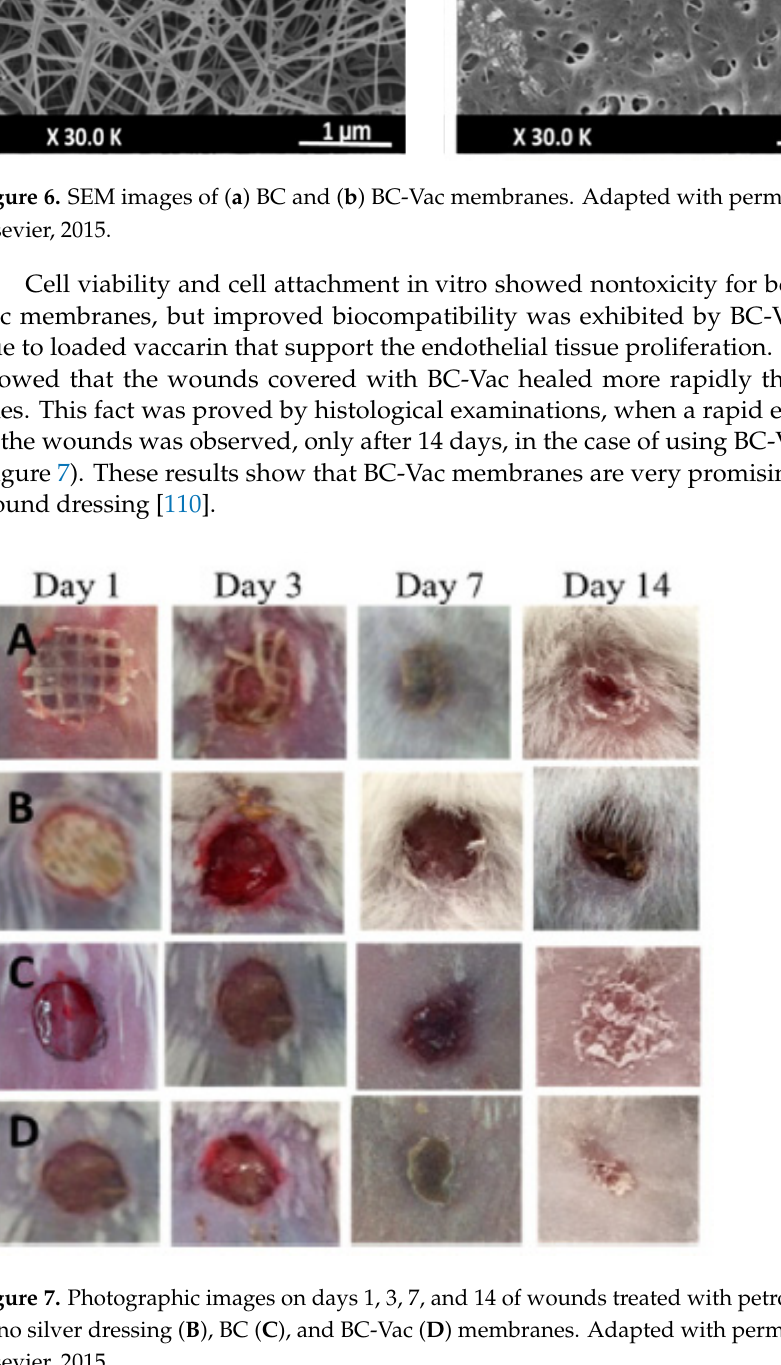
Figure 6. SEM images of ( a ) BC and ( b ) BC-Vac membranes. Adapted with permission from the authors of [110]. Copyright 2015 Elsevier.